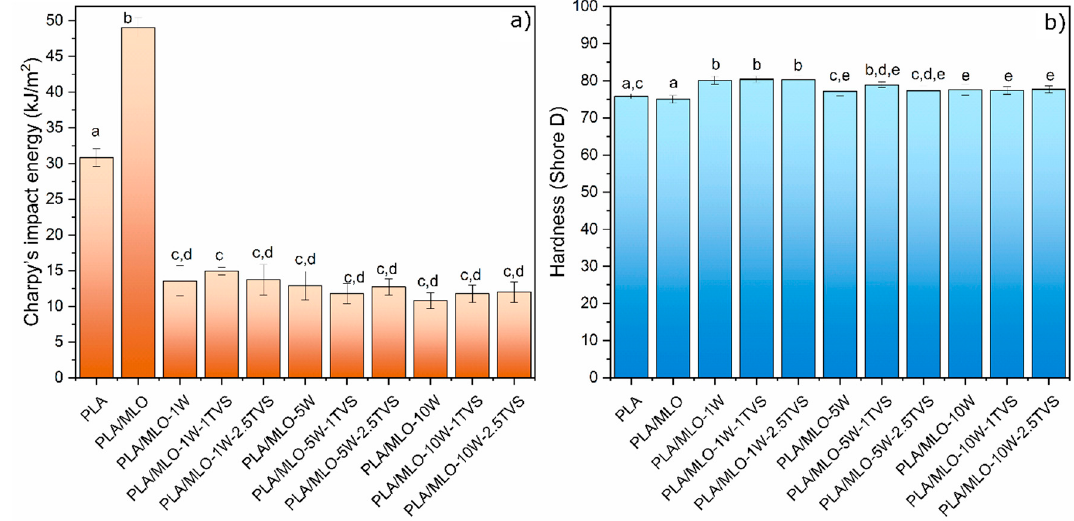
Figure 7. ( a ) Charpy’s impact values and ( b ) Shore D hardness values of the formulated materials. a– e Different letters within the same property show statistically significant differences between formulations ( p < 0.05).